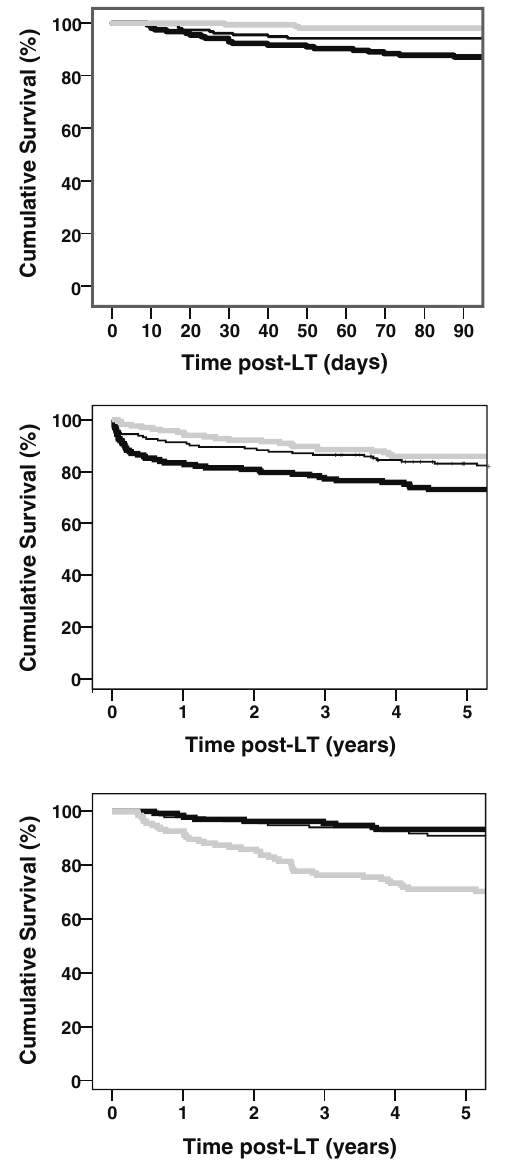
Figure 3. Kaplan–Meier analysis showing the opposite relationships of early and late GGT levels with early and late mortality. Panels A and B represent survival analysis post-LT in relation to GGT tertiles at POD 7, within 90 days and five years respectively ( p =0.003). Panel C demonstrates five-year survival in relation to GGT tertiles at six months post-LT ( p <0.001). Curves represent low (thick black), intermediate (thin black), and high GGT